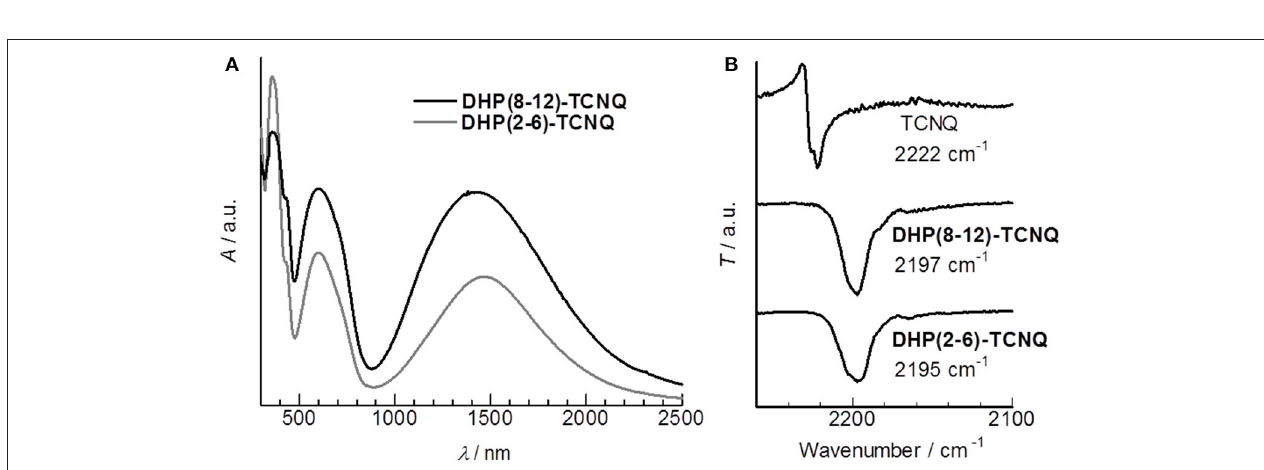
FIGURE 2 | (A) UV-Vis-NIR spectra of the cast film of DHP(8-12)-TCNQ (black) and DHP(2-6)-TCNQ (gray). (B) IR spectra of TCNQ, DHP(8-12)-TCNQ , and DHP(2-6)-TCNQ with each wavenumber value for C ≡ N stretching vibration ( ν C ≡ N ).